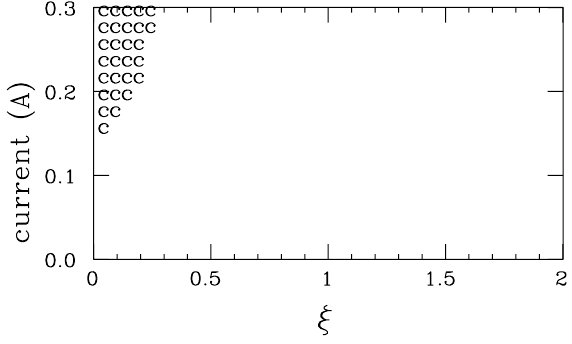
FIG. 9. Instability predictions which include dipole- quadrupole mode coupling, for active Landau-cavity opera- tion with the Aladdin lattice and b 2 (cid:1) 160 . c: coupled-bunch instability with longitudinal mode number of